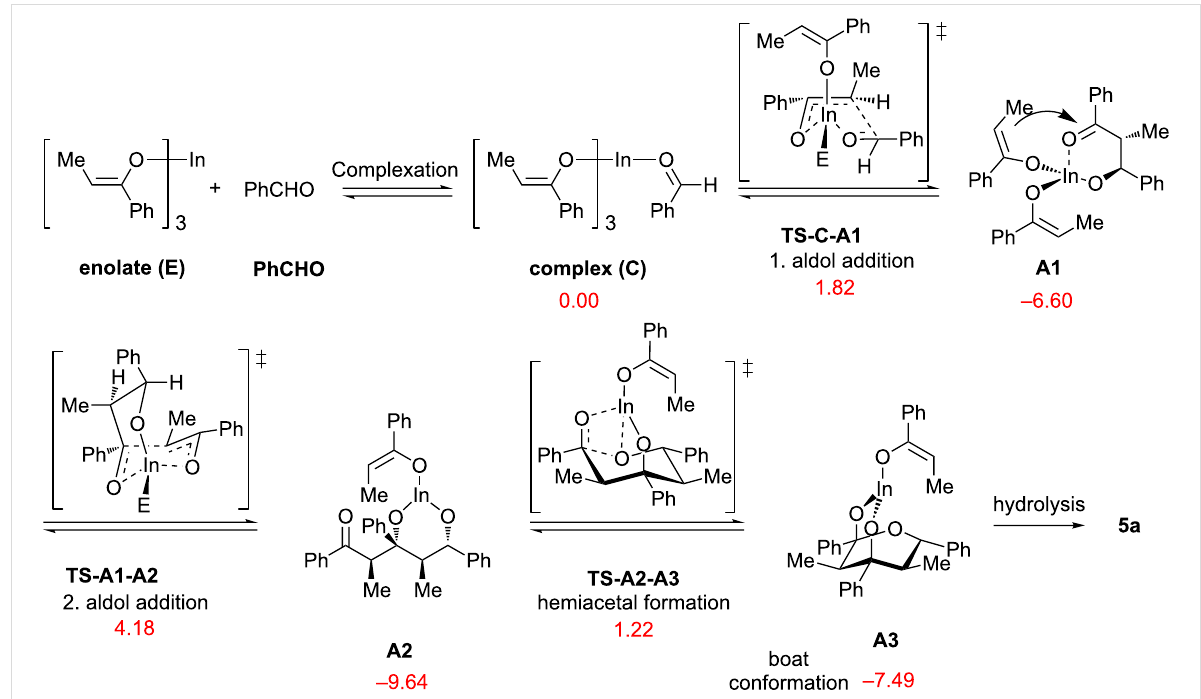
Scheme 6: DFT calculations on the formation of A3 , hydrolysis of which provides 5a , at M06/6-31G(d)/LANL2DZ//B3LYP/6-31G(d)/LANL2DZ level ( Δ G rel with unscaled zpe are in kcal mol − 1